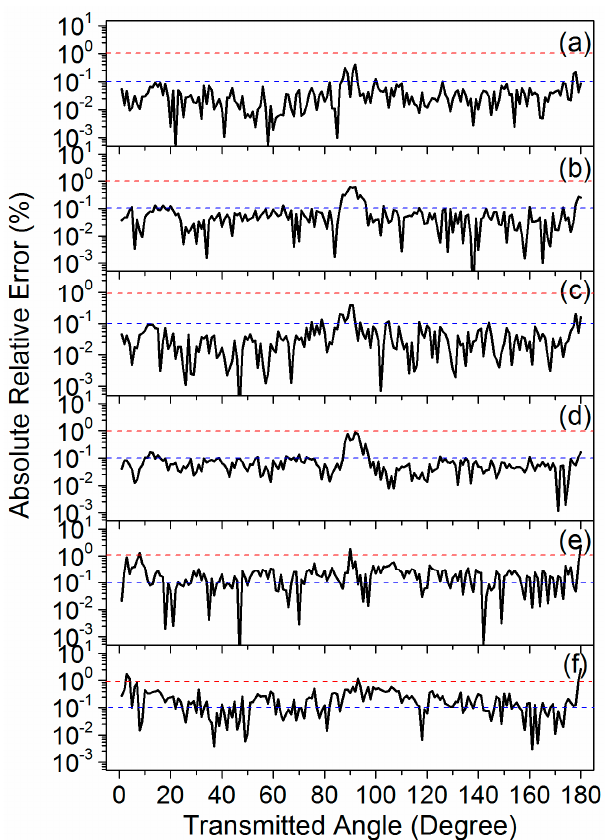
Figure 13. Absolute relative error of Markov chain angular distribution predictions compared to Monte Carlo, with OD discretization scheme 1 and modified Markov Inversion. Panel ( a ). Phase function 1, OD = 2; Panel ( b ). Phase function 1, OD = 5; Panel ( c ). Phase function 2, OD = 2; Panel ( d ). Phase function 2, OD = 5; Panel ( e ). Phase function 3, OD = 2; Panel ( f ). Phase function 3, OD = 5. Red dash lines indicate an error threshold of 1.0%, and blue dashed lines indicate a threshold of 0.1%.